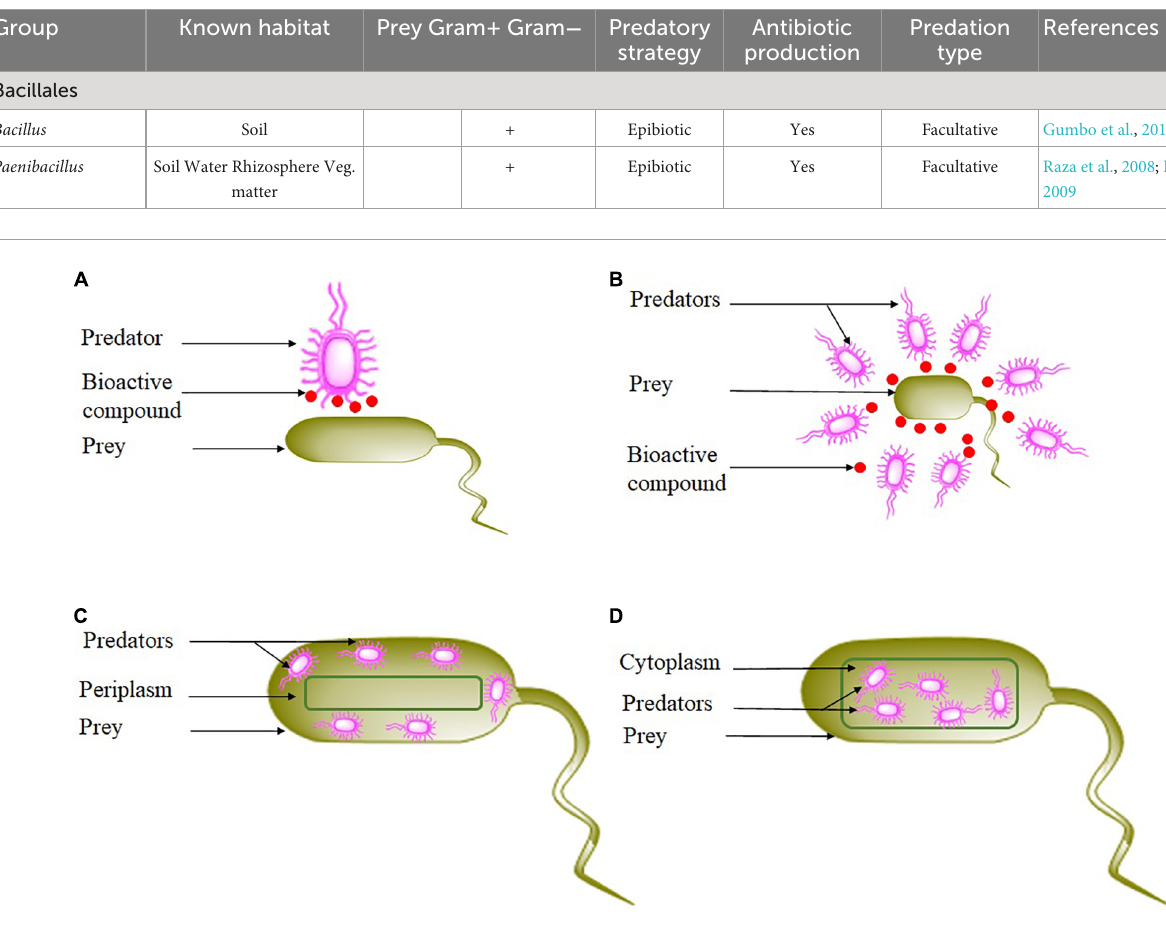
FIGURE1 Bacterial hunting strategies. (A) Epibiotic strategy, (B) wolfpack strategy, (C) periplasmic strategy, and (D) endobiotic